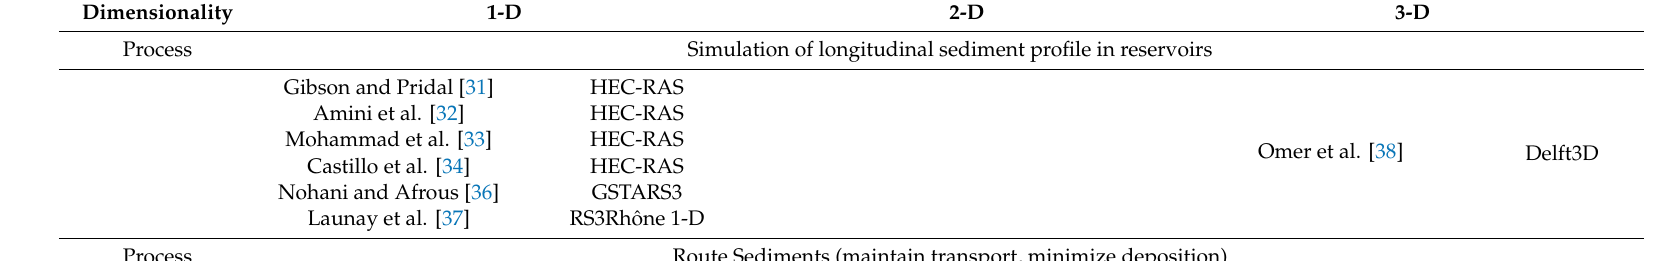
Table 2. Published reservoir sediment management